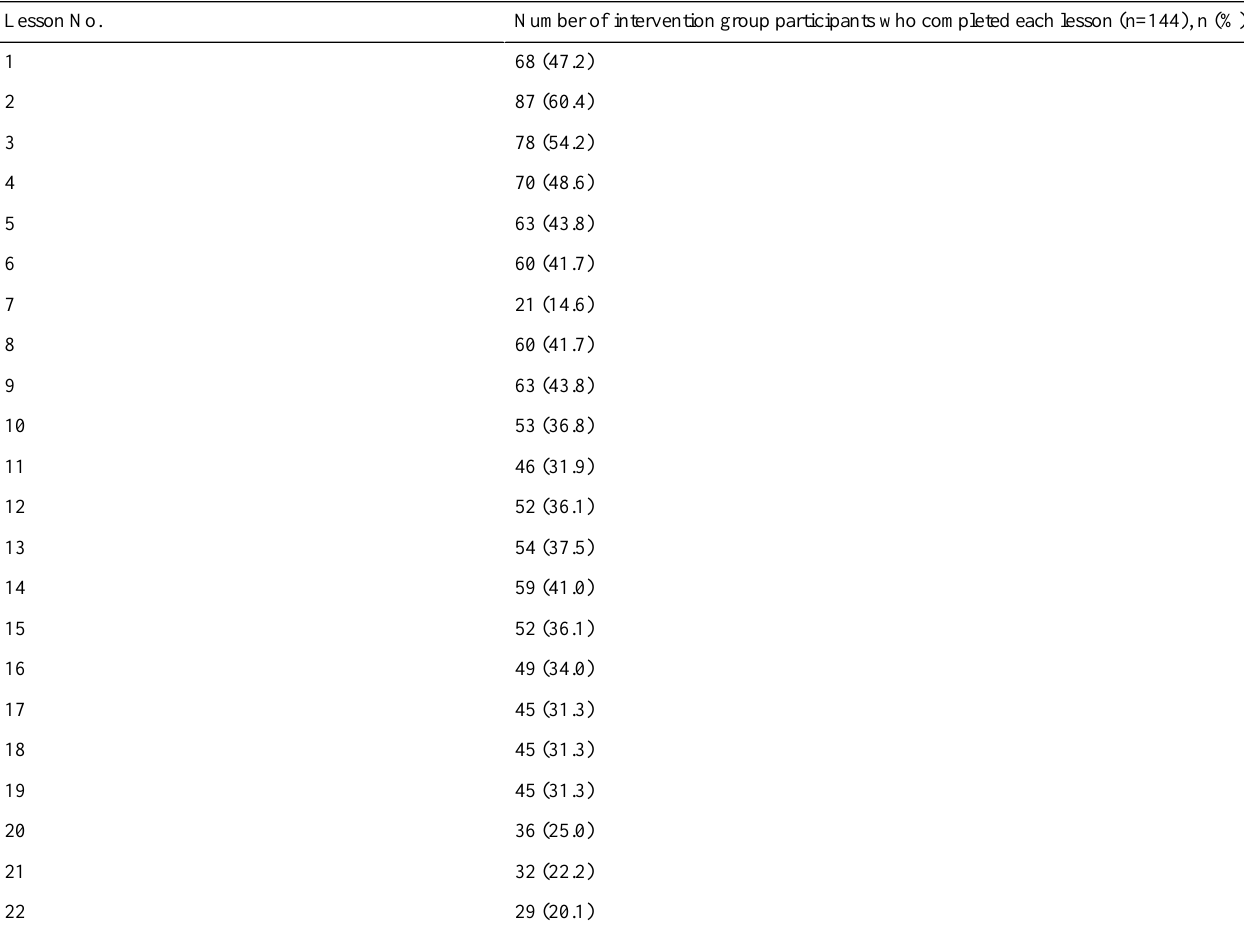
Table 4. Number of participants in the intervention group who completed